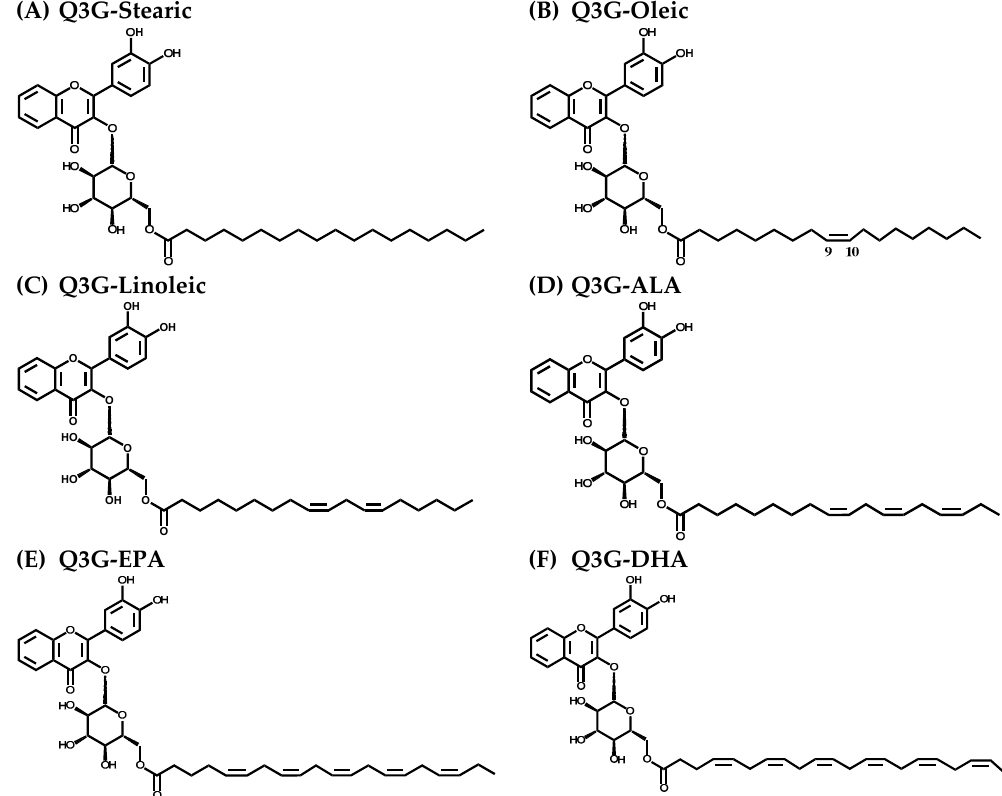
Figure 1. Chemical structures of six long chain fatty acid esters of quercetin-3- O -glucoside (Q3G). ( A ) Stearic acid ester of Q3G; ( B ) Oleic acid ester of Q3G; ( C ) Linoleic acid ester of Q3G; ( D ) α -linolenic acid (ALA) ester of Q3G; ( E ) eicosapentaenoic acid (EPA) ester of Q3G; ( F ) docosahexaenoic acids (DHA) ester of Q3G.